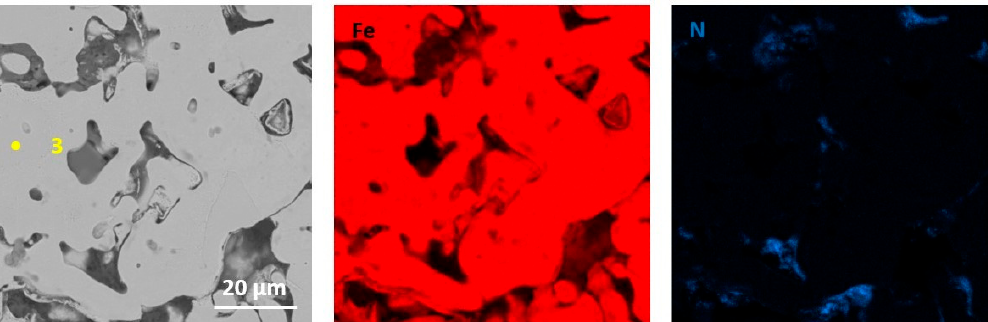
Figure 13. EDS mapping of sintered Fe with the addition of h-BN with a size of 0.5 μ m (for pressing pressure 350 MPa).